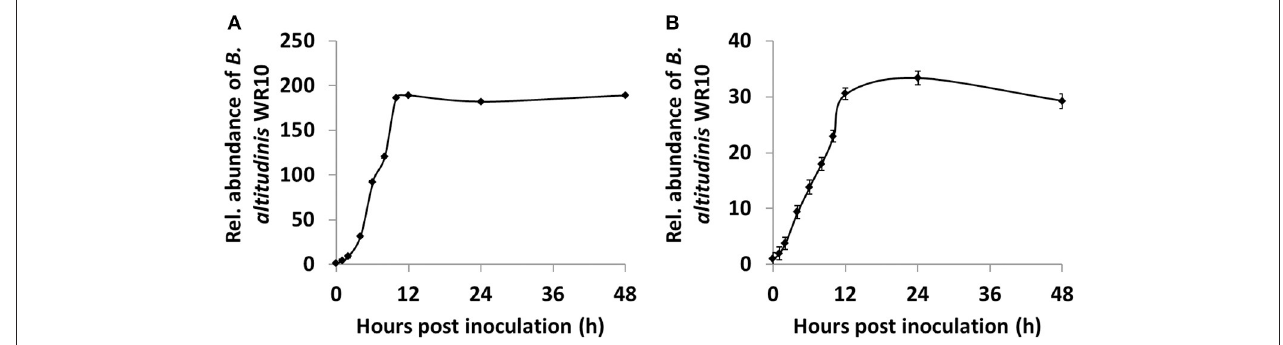
FIGURE 4 | Quantification of B. altitudinis WR10 in different wheat tissues during hydroponic coculture by qPCR assay. (A) The relative abundance of endophytic B. altitudinis WR10 in the root; (B) relative abundance of endophytic B. altitudinis WR10 in the sprout. At 0 phi, the relative abundances in different tissues were considered as 1. Fold changes were calculated by the 2 1 Cq method, which uses the copy numbers of the GAPDH gene representing the abundance of B. altitudinis WR10. Data were mean of three repeats from the genomic DNA mixture of six